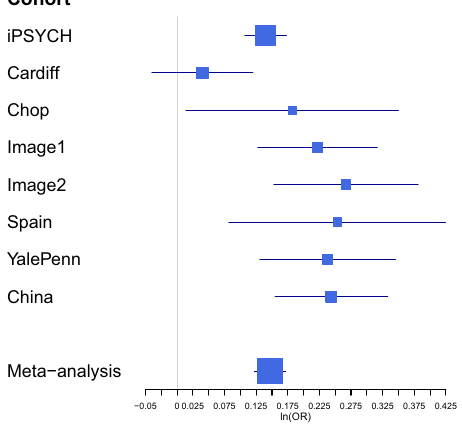
Fig. 2 Forest plot for the index variant in the genome-wide signi fi cant locus for ADHD + DBDs on chromosome 11. Forest plot for the index variant (rs7118422) in the genome-wide signi fi cant locus on chromosome 11. Visualization of the effect size estimates (natural logarithm of the odds ratio (ln(OR)) in each included cohort, estimated from logistic regression, and in the trans-ancestry GWAS meta-analysis of European and Chinese cohorts (4208 cases and 32,222 controls) using an inverse-variance weighted fi xed effects model. In addition, standard errors of the ln(OR) estimates. For information on sample sizes, allele frequencies and P -values for rs7118422 in the single cohorts see Supplementary Data